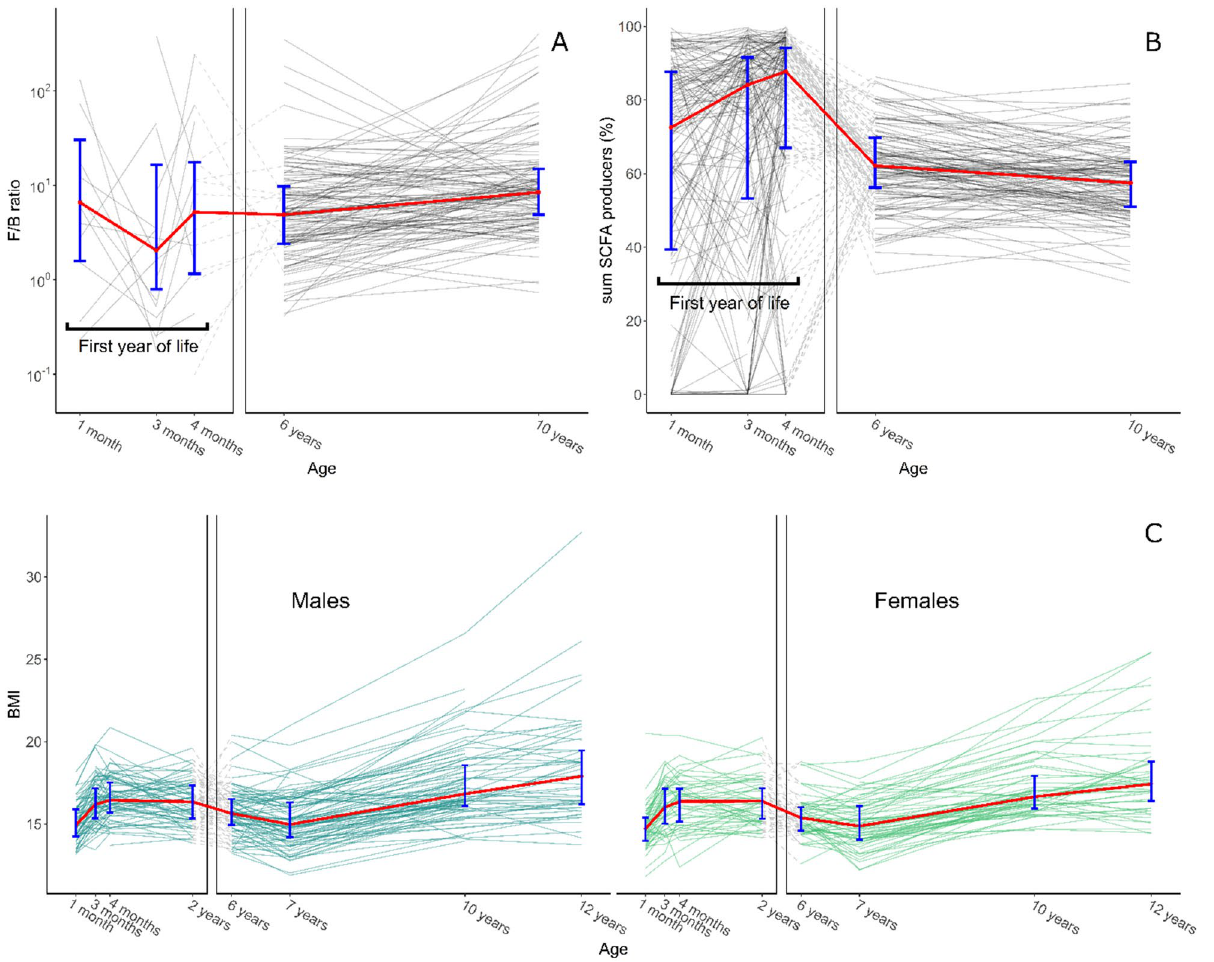
Figure 1. Individual and median trajectories of microbiota variables and BMI. ( A ) Individual and median (in red) trajectories of F/B ratio on log10 scale over time. ( B ) Individual and median trajectories of relative abundance of sum SCFA producers over time. ( C ) Individual and median (raw) BMI trajectories over time split by sex. Error bars indicate interquartile range (IQR). Please note the break in the x-axis. The lines crossing the break do not represent the actual slope and are only plotted to show individual growth